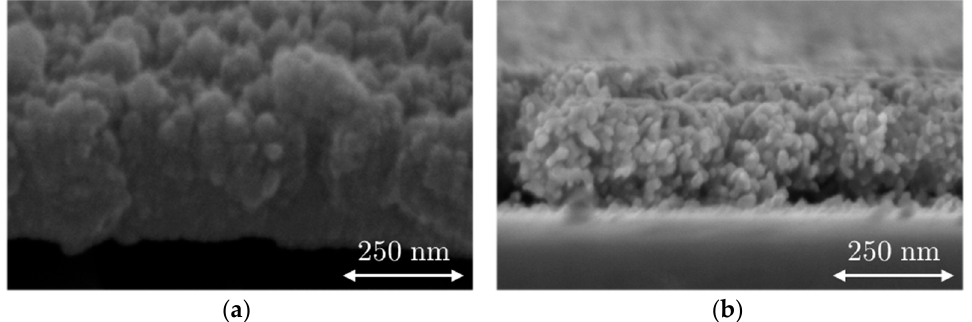
Figure 3. SEM images of the B-Al layer ( a , c ) and the B-Au layer ( b , d ) deposited on QCM sensors. ( c ) Cross section of B-Al layer and ( b ) cross-section of the B-Au layer.